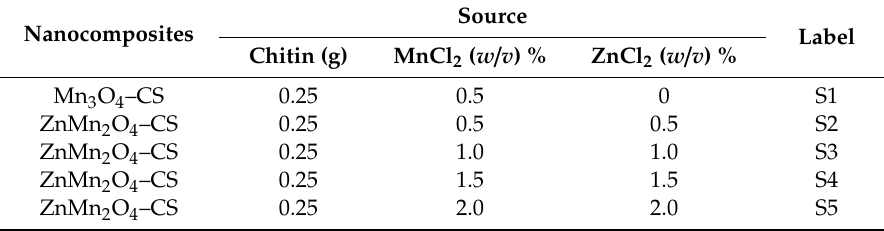
Table 1. The chemical source ratios for the Mn 3 O 4 –CS and ZnMn 2 O 4 –CS composites.